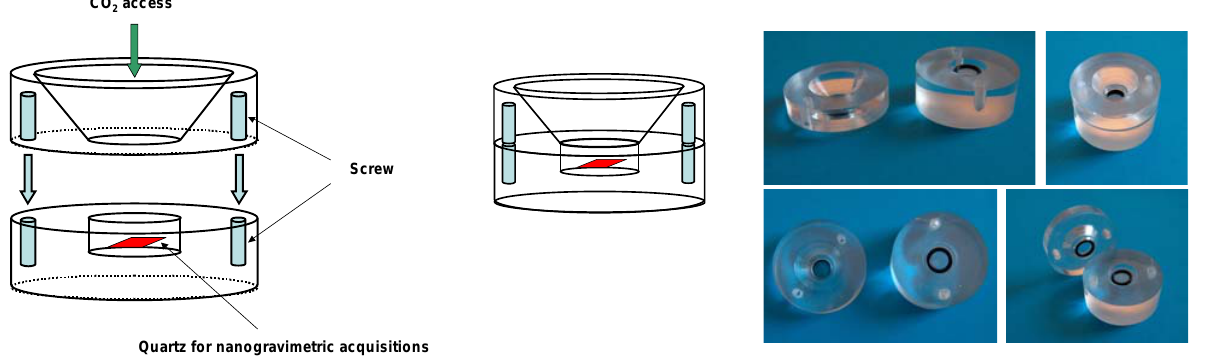
Figure 1. Illustration of the plastic cell containing the quartz for environmental CO long-term sampling, constructed in cooperation with Elbatech Srl, Marciana, Italy.